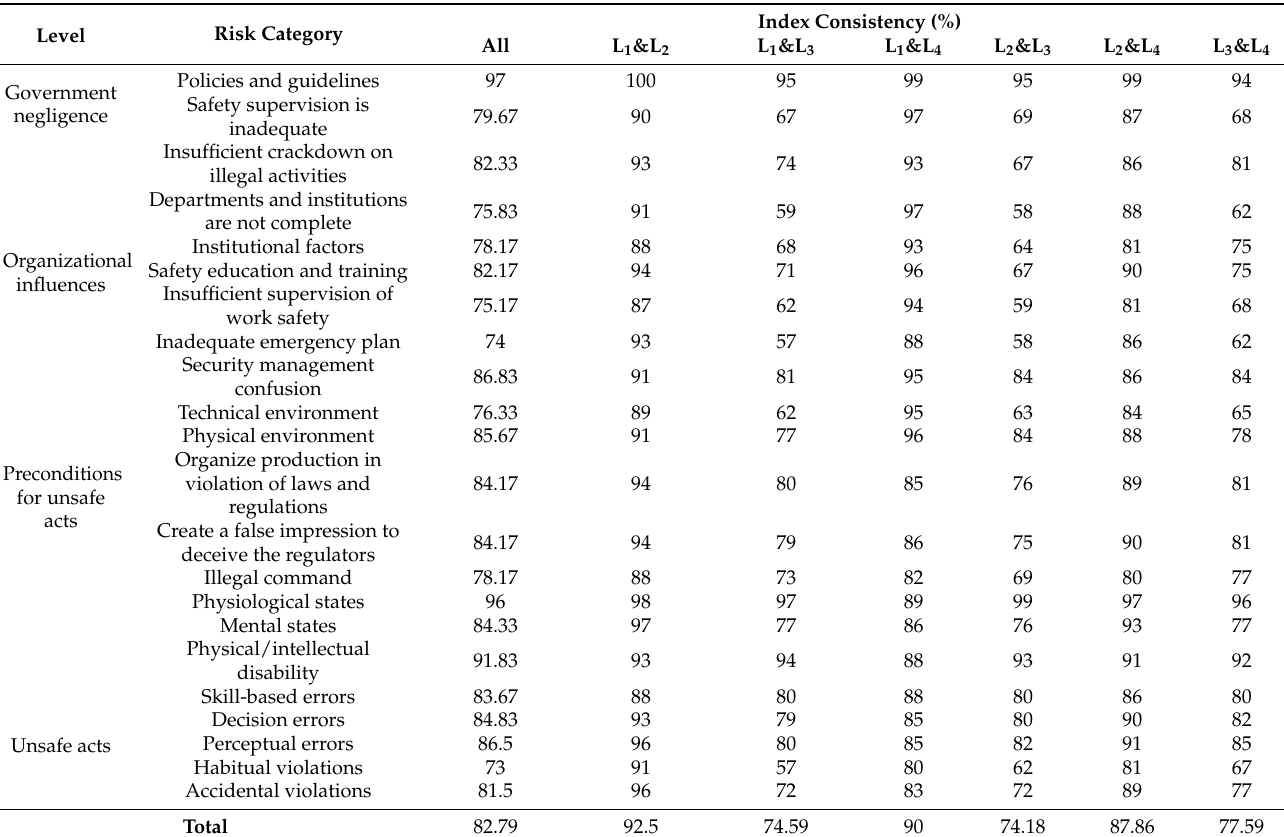
Table 3. Reliability test results of the HFACS-GE